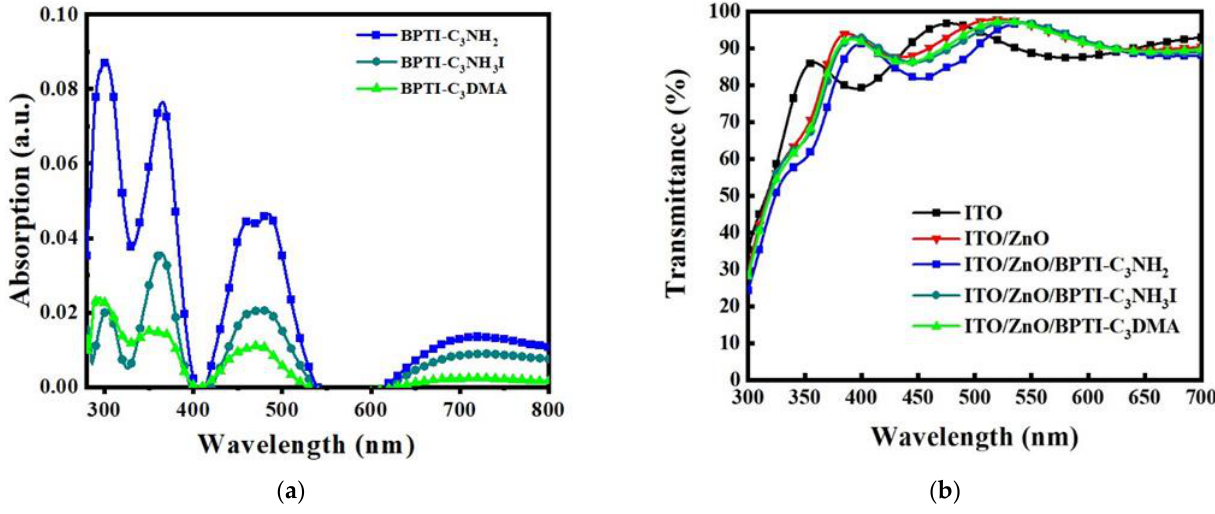
Figure 2. ( a ) UV – Vis absorption spectra of the BPTI films and ( b ) UV – Vis transmittance spectra of Figure 2. ( a ) UV–Vis absorption spectra of the BPTI films and ( b ) UV–Vis transmittance spectra of the ITO/ZnO/BPTI samples. the ITO/ZnO/BPTI